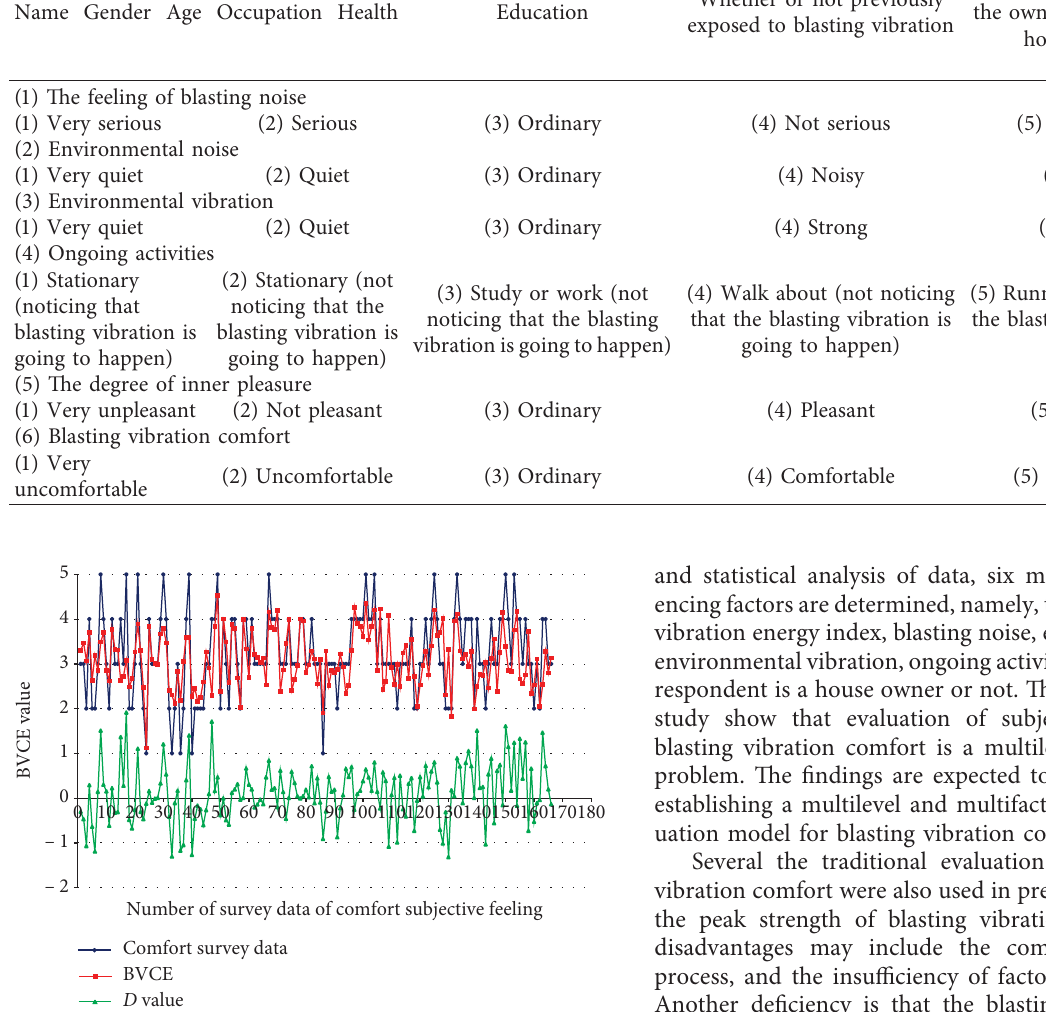
Figure 3: Comparative analysis on ABVE evaluation results and comfort survey